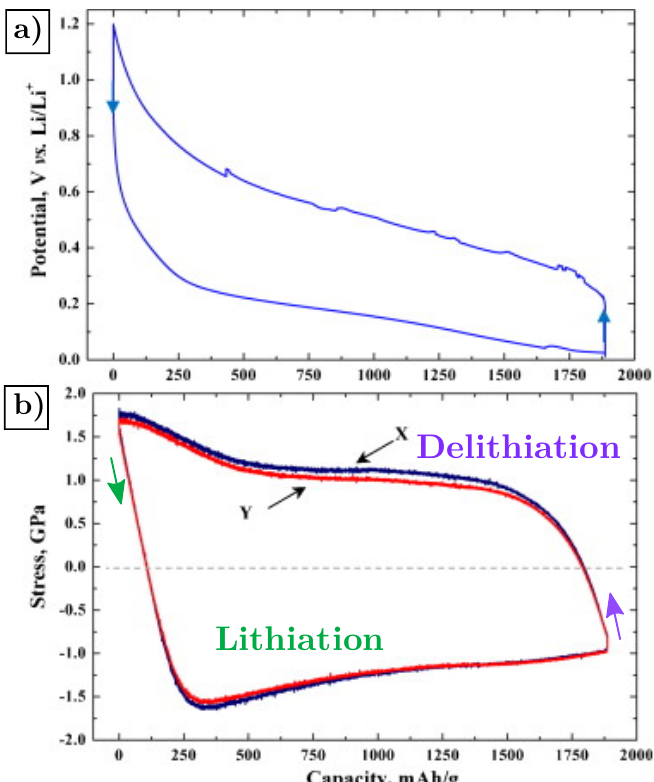
Figure 7. ( a ) Cell potential vs. capacity curve corresponding to lithiation and delithiation Si thin − film electrode cycled at C/4 rate, and ( b ) the corresponding average stress computed from the measured curvature of the substrate. Adapted with permission by Elsevier from [56], Copyright